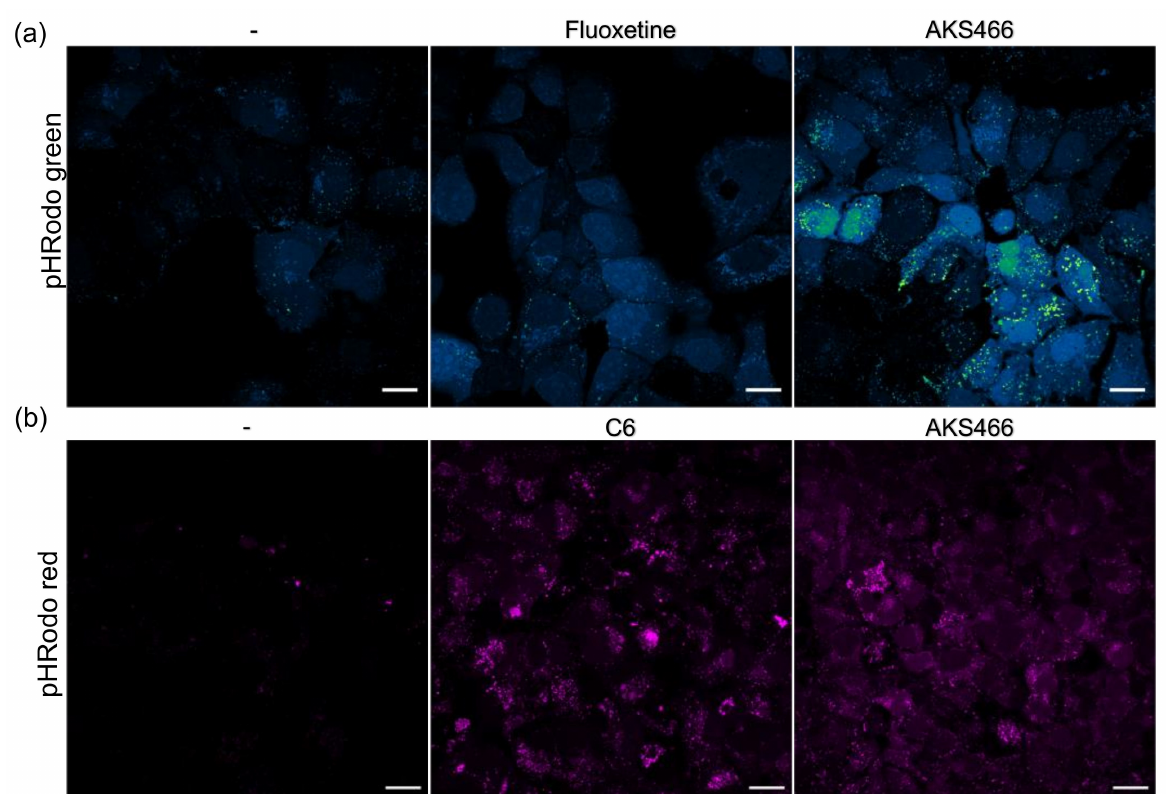
Figure 5. AKS466, fluoxetine, and C6 ceramide decrease the lysosomal pH. ( a ) Huh-7 cells were incubated with fluoxetine (5 mM) and AKS466 (20 µ M). The lysosomal pH was visualized in a live-cell image with a pHrodo green stain. ( b ) The influence of ORF3a on the lysosomal pH was analyzed after AKS466 and C6 treatment of ORF3A expressing Huh-7 cells. Scale bars = 20 µ